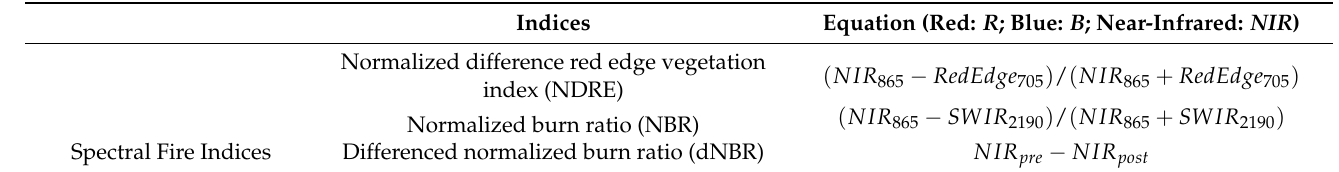
Table 3. Cont. Indices Equation (Red: R ; Blue: B ; Near-Infrared: NIR ) Normalized difference red edge